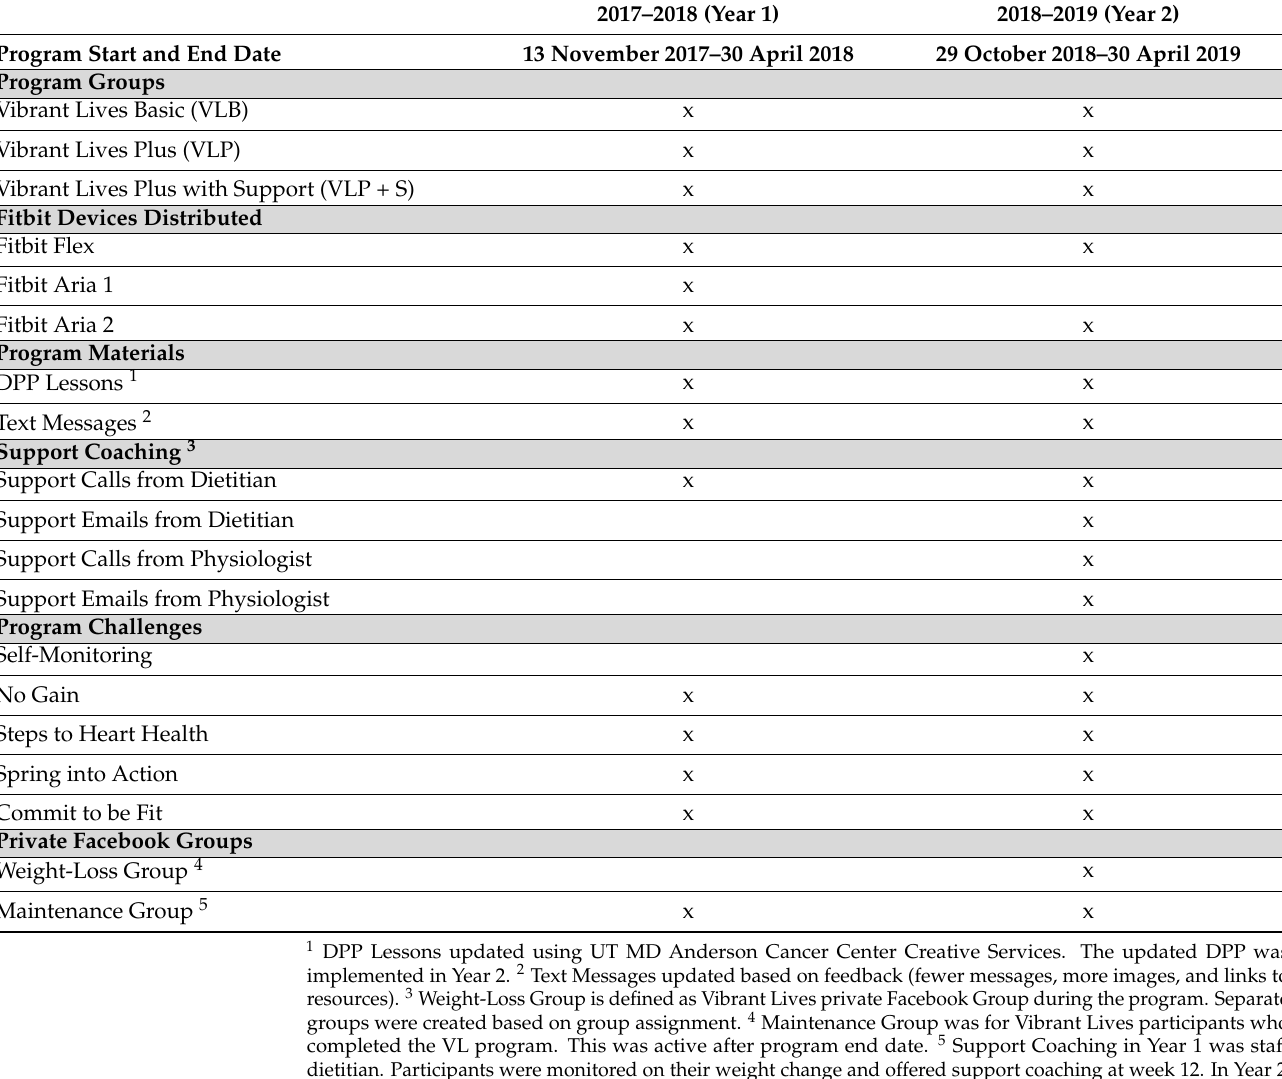
Table 2. Vibrant Lives program